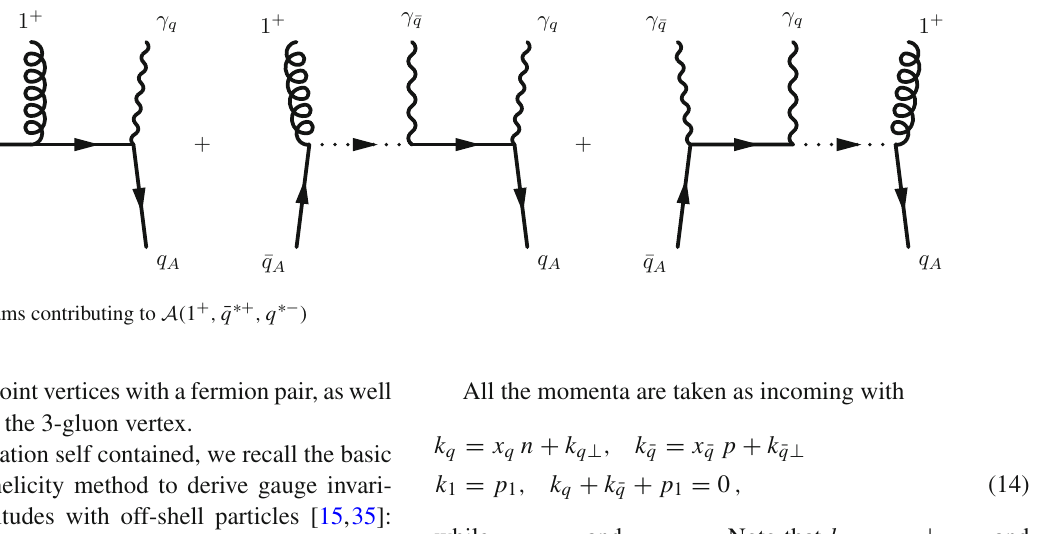
(11)–(13) for the 3-point vertices with a fermion pair, as well as the result (29) for the 3-gluon